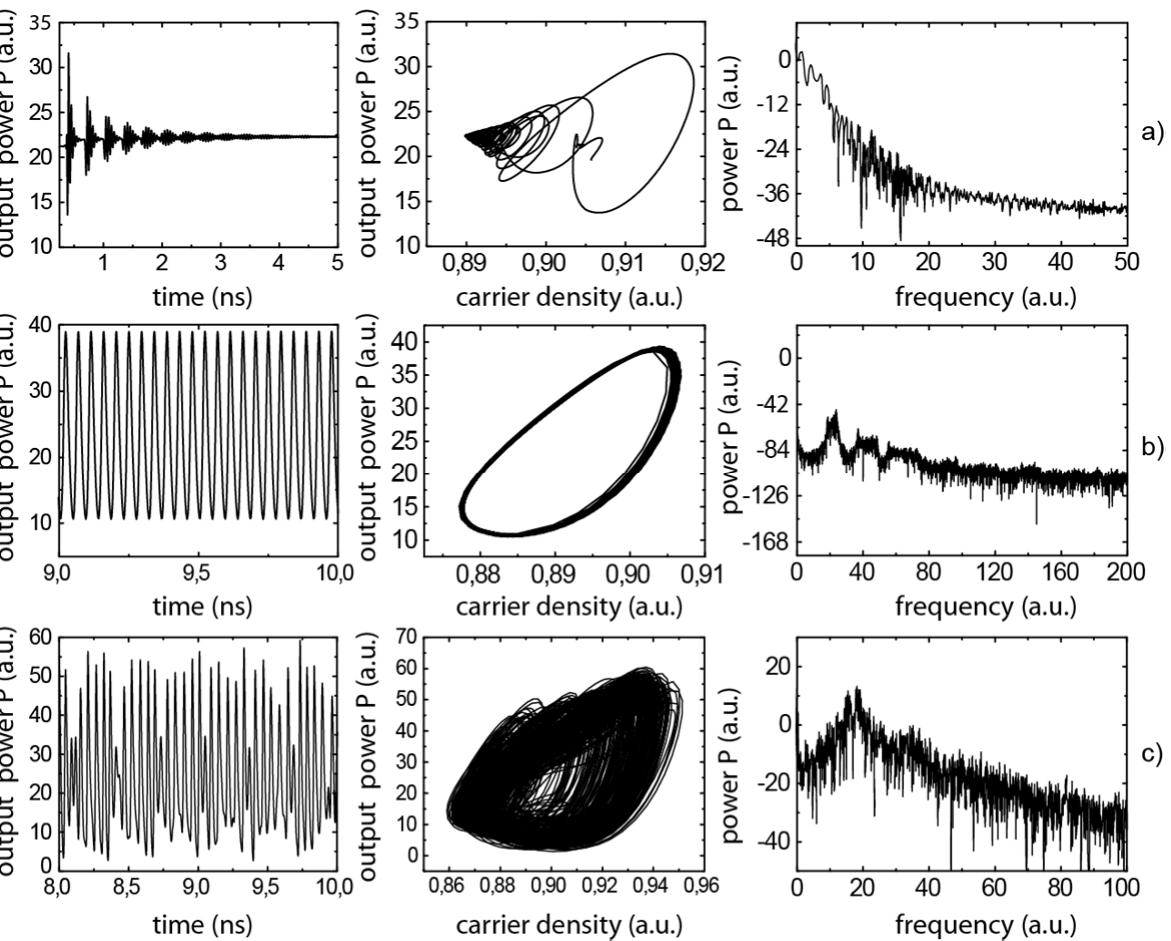
Figure 4. A typical optical power time trace (left), phase portrait (center) and the power spectrum (right) of a semiconductor laser is shown in Figure 1 for: a) 